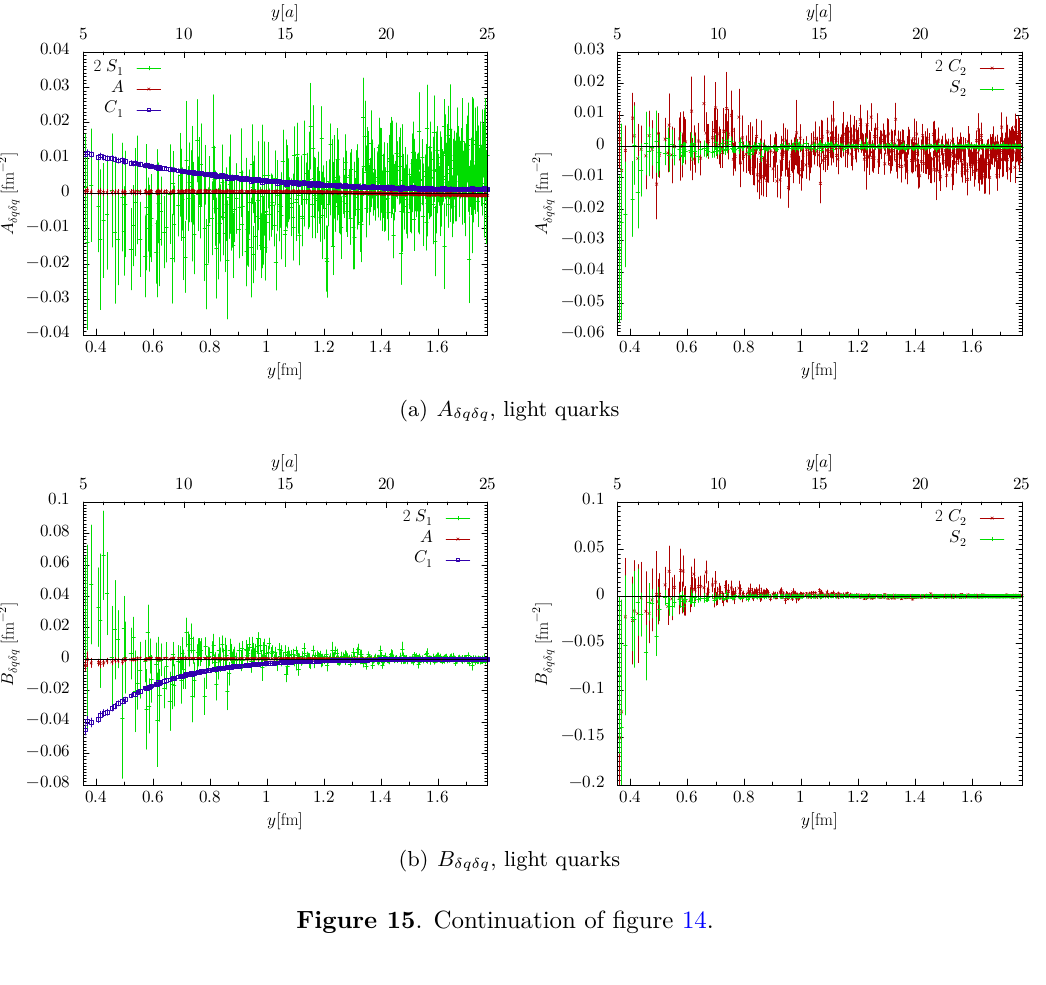
Figure 15 . Continuation of figure 14.